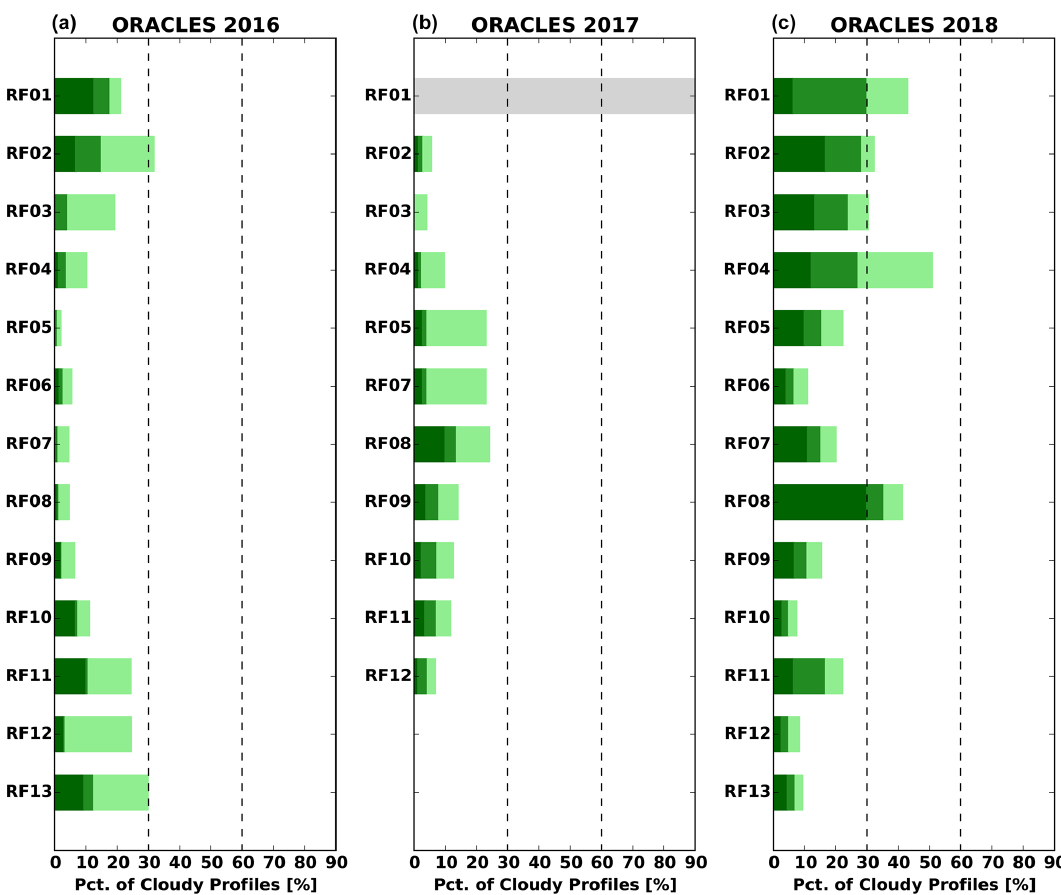
Figure 17. The fraction of clouds in which rain is possible, probable, and certain, for the ORACLES research flights in 2016 (a) , 2017 (b) , and 2018 (c) as detected using the APR-3 radar. Certain rain (dark green), probable rain (medium green), and possible rain or drizzle (light green) are shown left to right for each research flight, which are determined by each cloudy profile’s maximum reflectivity being greater than 0, − 7 . 5, and − 15dBZ respectively (see Haynes et al., 2009, for more